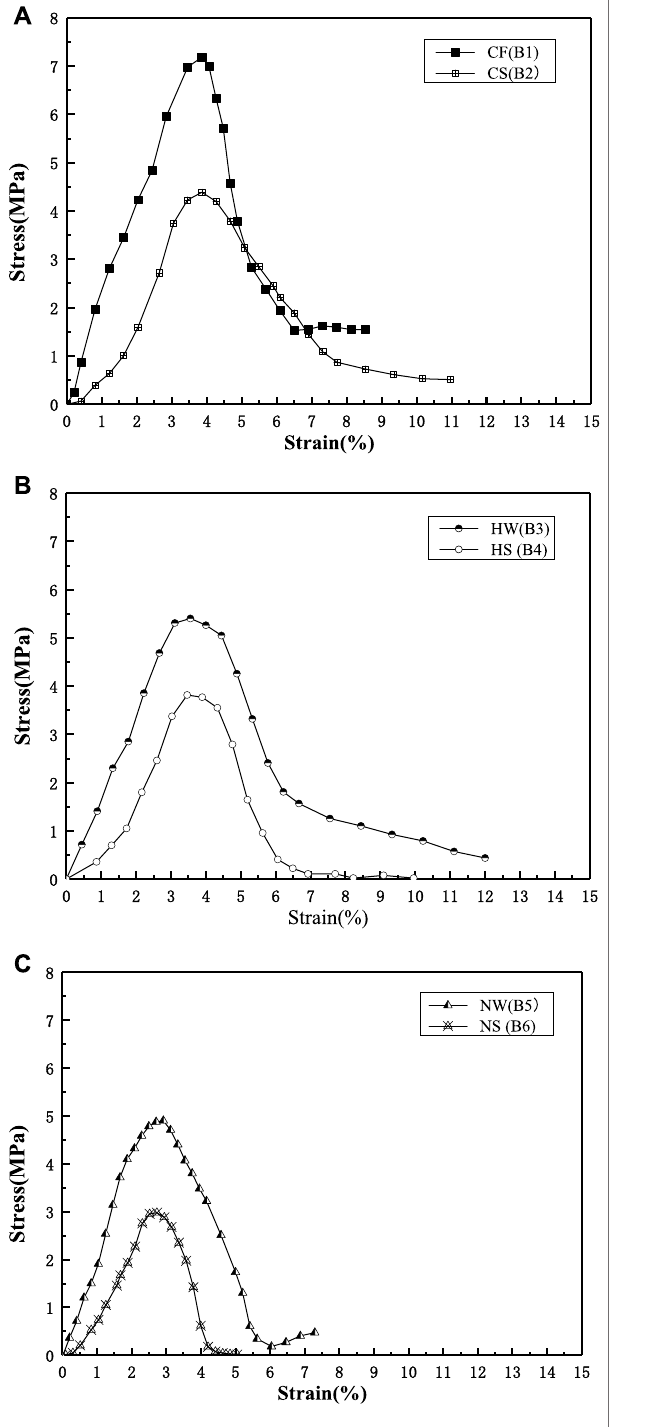
FIGURE 4 | Uncon fi ned compression strength (UCS) in Group B of freshwater and seawater environment. (A) Group B CaCl 2 ; (B) Group B Ca(CH 3 COO) 2 ; (C) Group B Ca(NO 3 ) 2 .